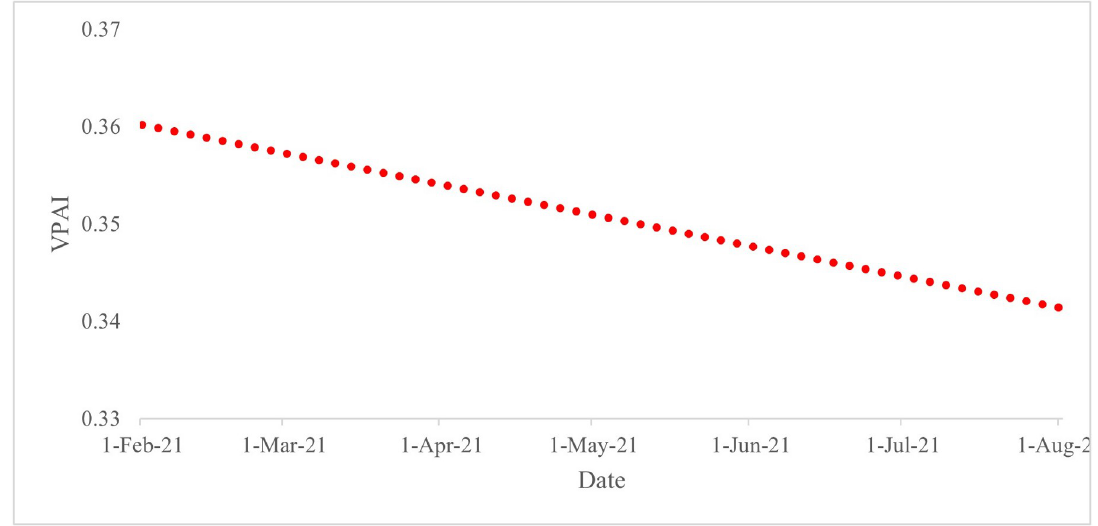
Fig 4. Trend in positive attitude from February 2021 to the end of July 2021 for the whole sample. Source: Authors’ calculations.